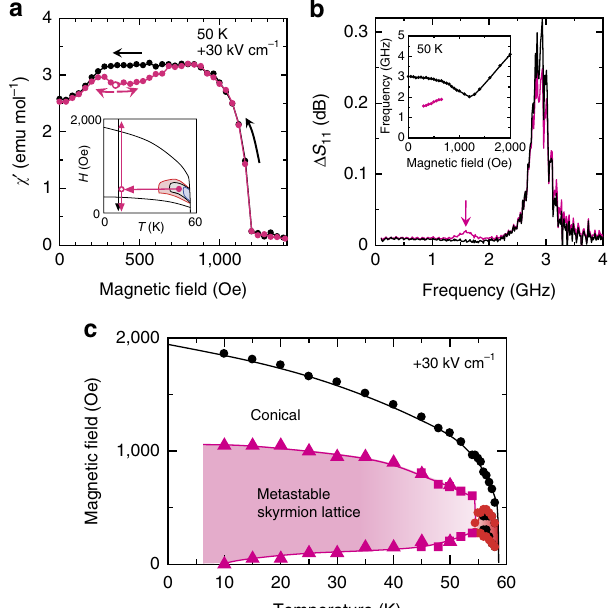
Figure 2 | Metastable skyrmion lattice realized by magnetic- and electric-field cooling. ( a ), The magnetic field dependence of the a.c. susceptibility w ’ measured after magnetic-field (350Oe) cooling under a field of þ 30kVcm (cid:2) 1 and then scanning the magnetic field up and down (magenta symbols), and alternatively by decreasing the magnetic field from the ferromagnetic phase (black symbols). The measurement procedures are schematically illustrated in the inset. T and H represent the temperature and magnetic field, respectively. The magenta and black arrows represent the measurement procedures for the data shown in the main panel with the corresponding colour. The open magenta symbol in the main panel corresponds to the point indicated by the open magenta symbol in the inset. ( b ), The microwave spectra measured after the ME cooling (magenta) and without ME cooling (black). D S 11 represents the microwave absorption coefficient. (inset) The magnetic field dependence of the resonance frequencies derived from the microwave spectra measured after the ME cooling. ( c ), The magnetic phase diagram including the metastable skyrmion state, under an electric field of þ 30kVcm (cid:2) 1 . Data points marked by magenta squares and triangles were determined via a.c. susceptibility measurements and microwave spectroscopy,